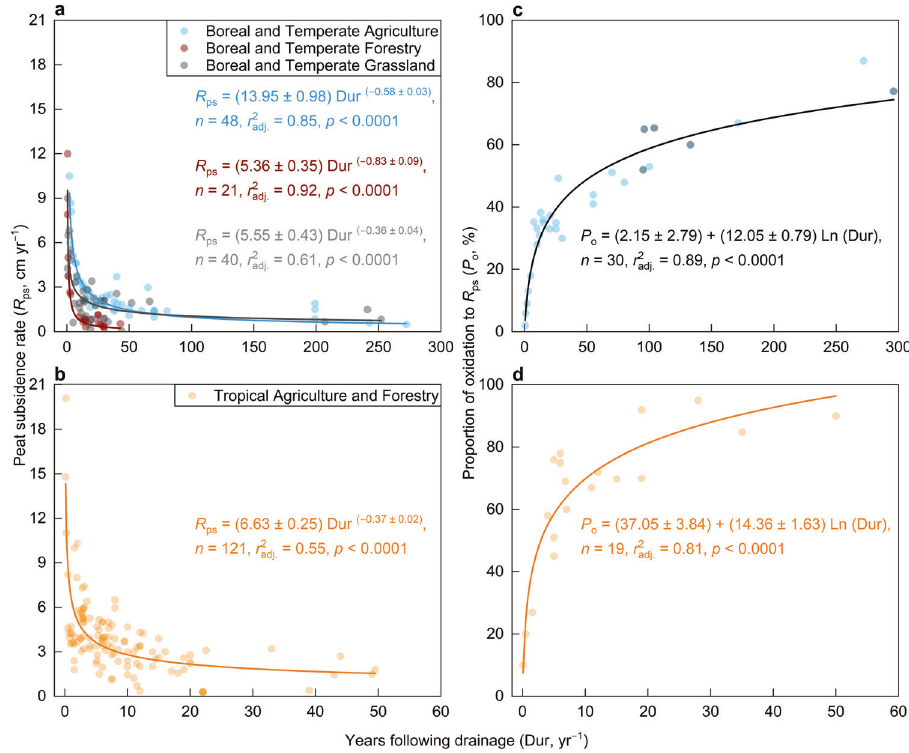
Fig. 5 Drainage duration controls peat subsidence rate ( R ps ) and the proportion of peat oxidation to R ps ( P o ). a , b Relationships of R ps with drainage duration (i.e., years since drainage) for drained peatlands across different climate zones and land uses. c , d Proportion of subsidence attributed to peat oxidation ( P o ) with drainage duration for drained peatlands across different climate zones and land uses. The fi tted regression curves and their 95% con fi dence intervals are shown. The same P o was used for drained boreal and temperate peatlands under different land use due to a lack of suf fi cient observations. Similarly, the same P o was used for drained tropical peatlands under different land